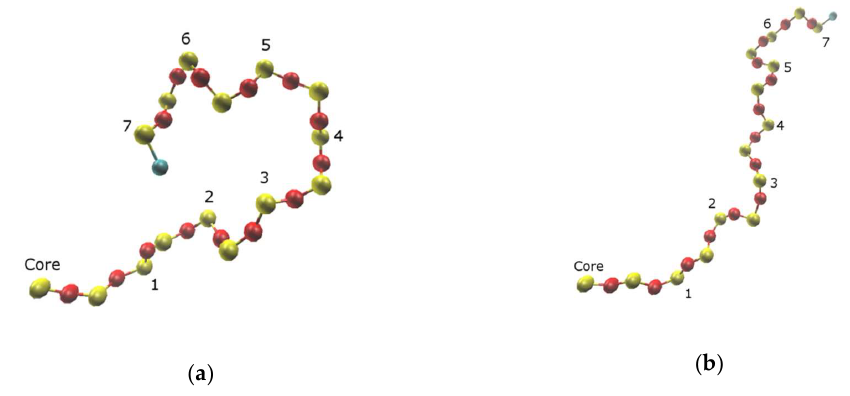
Figure 8. Two instant conformations ( a , b ) of one isolated linear chain of the generation-7 (G7) l-dendrimer, from the core Si atom to the terminal group, taken within an interval of 100 ps. The Si branching atoms are numbers from the core.